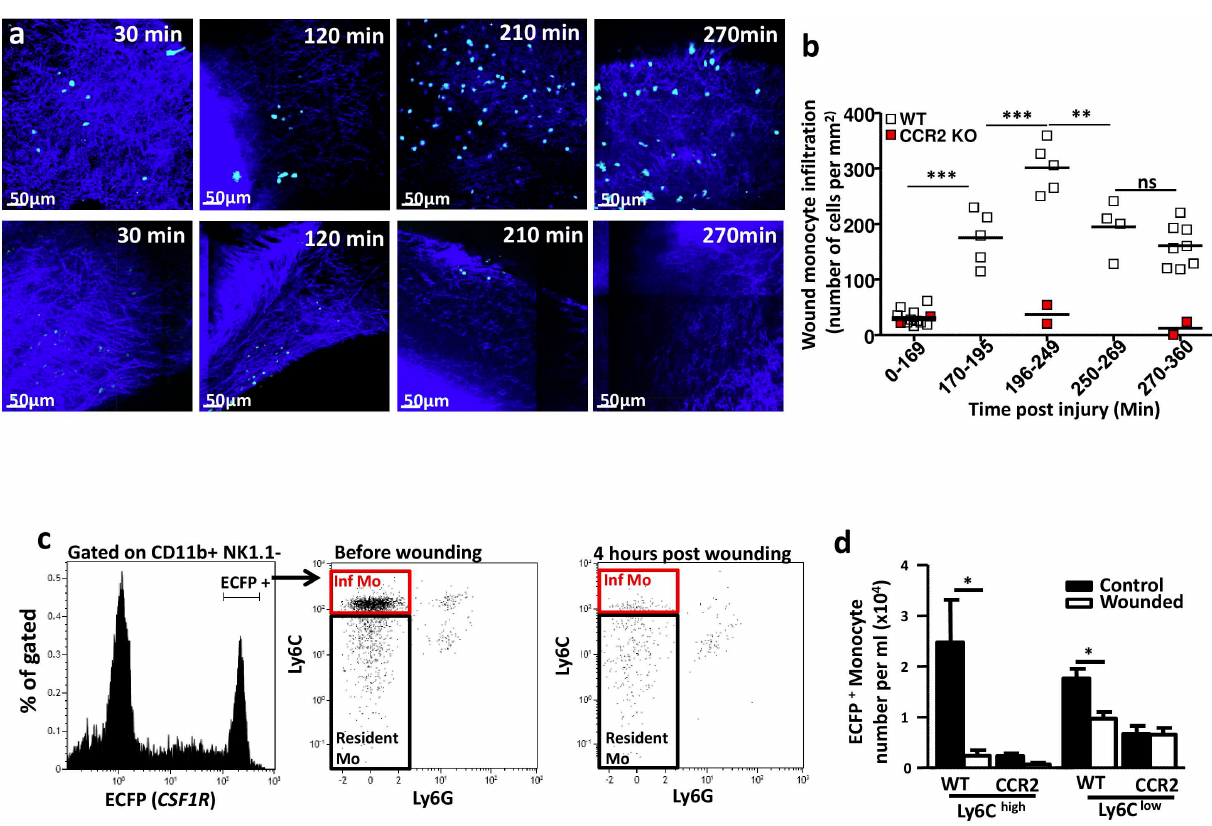
Figure 2. The skin wound induced a rapid and transient wave of monocyte recruitment. ( a ) Representative TPLSM picture of the wound deep skin layer from MacBlue 6 CX3CR1 gfp/ + and MacBlue 6 CX3CR1 gfp/ + CCR2 2 / 2 mice at several time points after wounding. The SHG signal is in blue, the ECFP signal in cyan, and the GFP signal in green. ( b ) Quantification of ECFP + cell density from TPLSM pictures taken 15 to 360 min post- wounding in MacBlue 6 CX3CR1 gfp/ + and MacBlue 6 CX3CR1 gfp/ + CCR2 2 / 2 mice. Each dot represents a mean number of ECFP cells calculated from 30 to 50 different fields (100 6 100 m m) from 3–8 mice. Time points were compared using one way ANOVA followed by Bonferroni adjustment. ( c ) Representative flow cytometry dot plots of Ly6C and Ly6G expression by ECFP + blood myeloid cells (gated on CD11b + , NK1.1 2 ) from MacBlue 6 CX3CR1 gfp/ + mice before and 4 hours after wounding. ( d ) Quantification of ECFP + Ly6C high inflammatory and Ly6C low resident monocytes in the blood of MacBlue 6 CX3CR1 gfp/ + and MacBlue 6 CX3CR1 gfp/ + CCR2 2 / 2 mice before and 4 hours after injury (n=4–7 from 3 independent experiments). Inf Mo: Inflammatory monocytes; Resident Mo: Resident monocytes. *p , 0.05; **: p , 0.01; ***: p , 0.001.